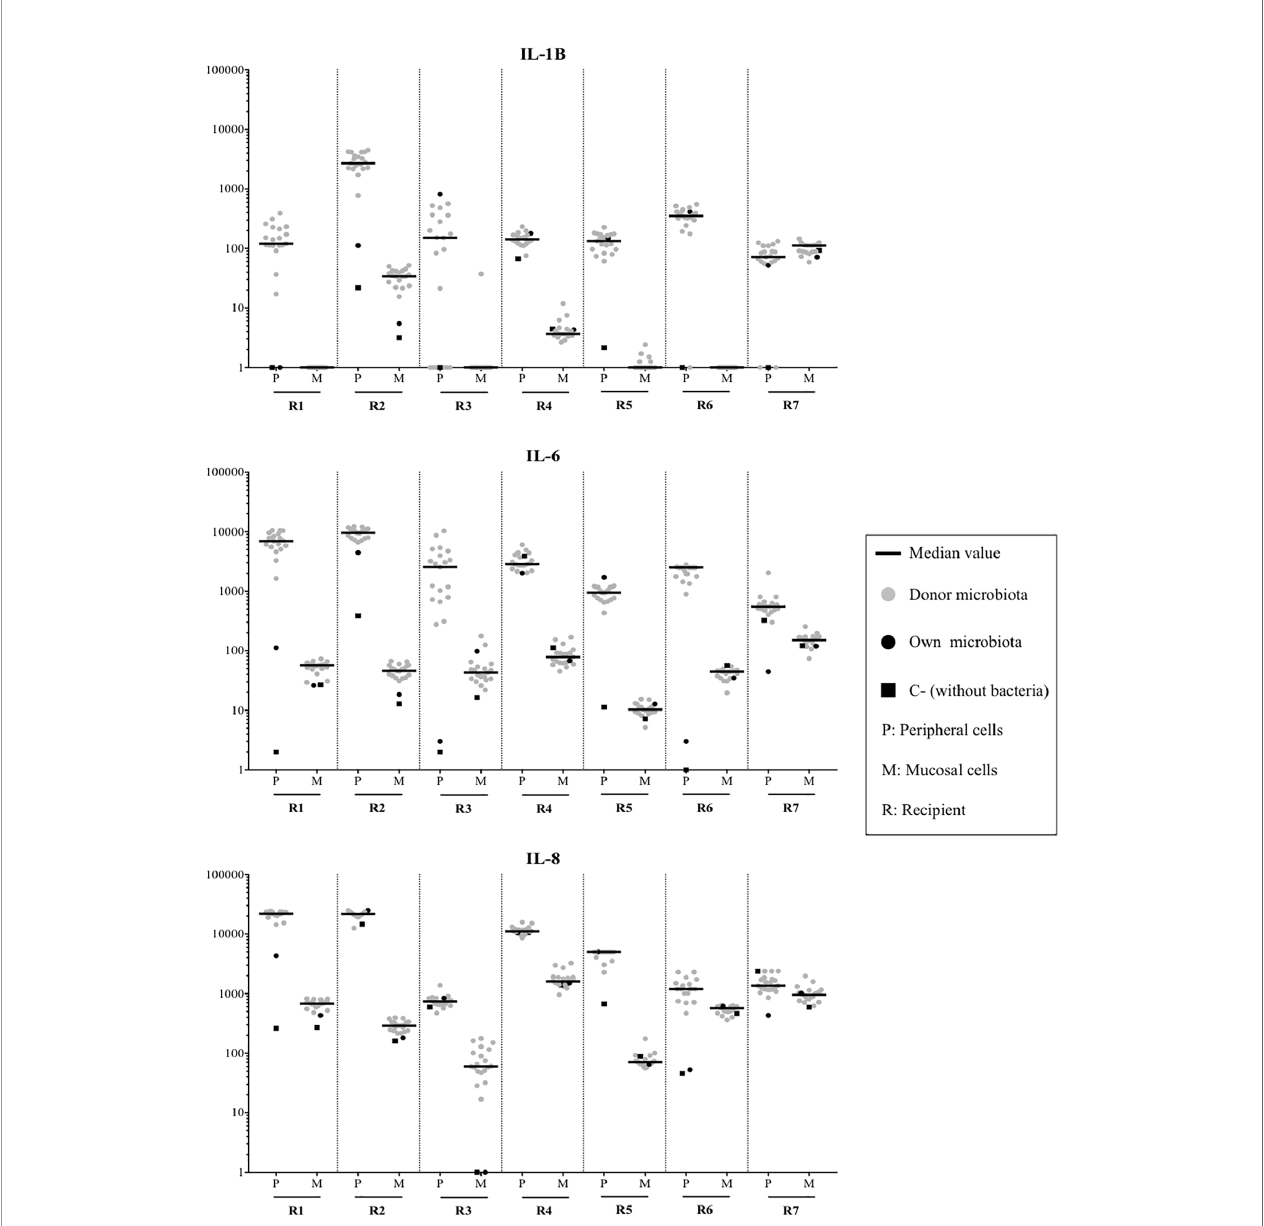
FIGURE 2 | Comparison of peripheral (P) and mucosal (M) immunological response for microbiota from 19 healthy donors, their own microbiota and a negative control without antigenic stimulus. The most variable markers (IL-1 b , IL-6 and IL-8) were shown. To note the logarithm scale of the Y